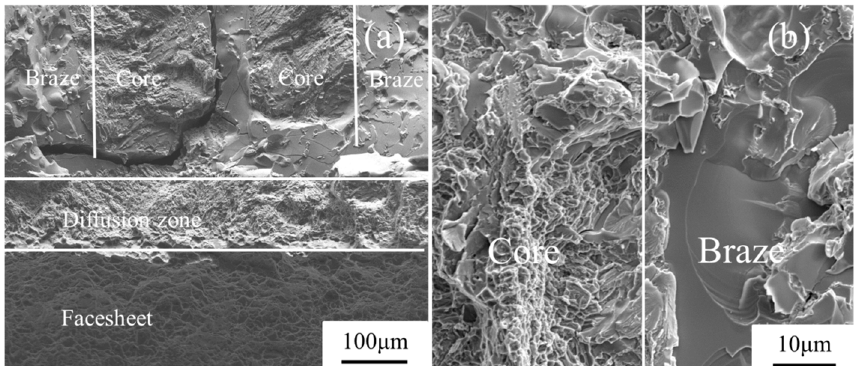
Figure 11. Micromorphology of the damaged W-direction sandwich panels at 20 °C: ( a ) the brazing joint region; ( b ) the magnified brazing region between the core and the brazing filler.